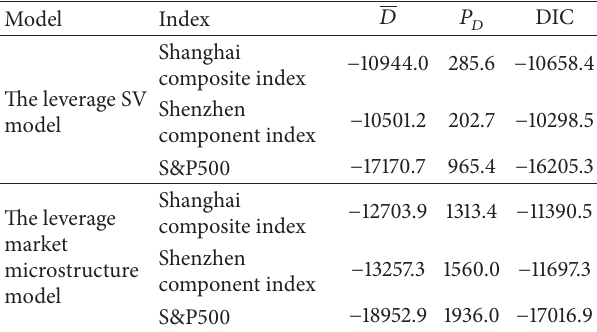
Table 7: DIC vales of two models for three